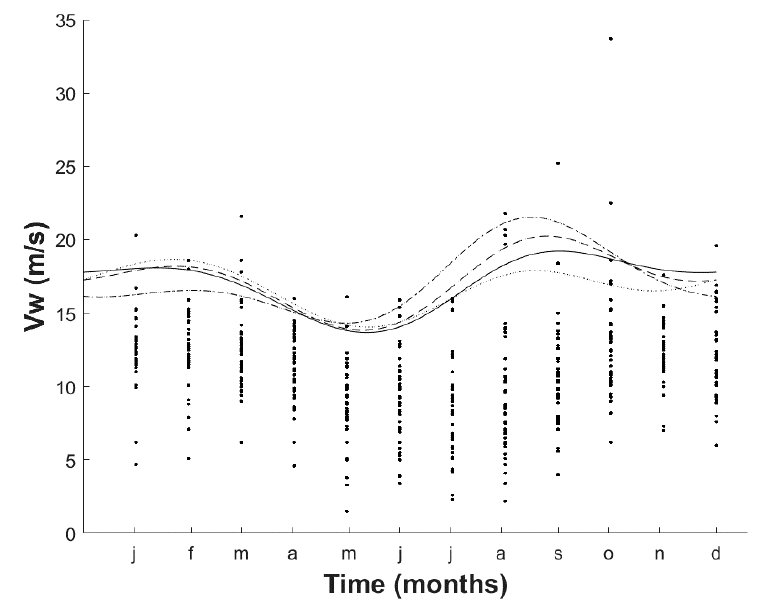
Figure 2. Monthly companion and 30-yr return period values of V w using different time ranges.